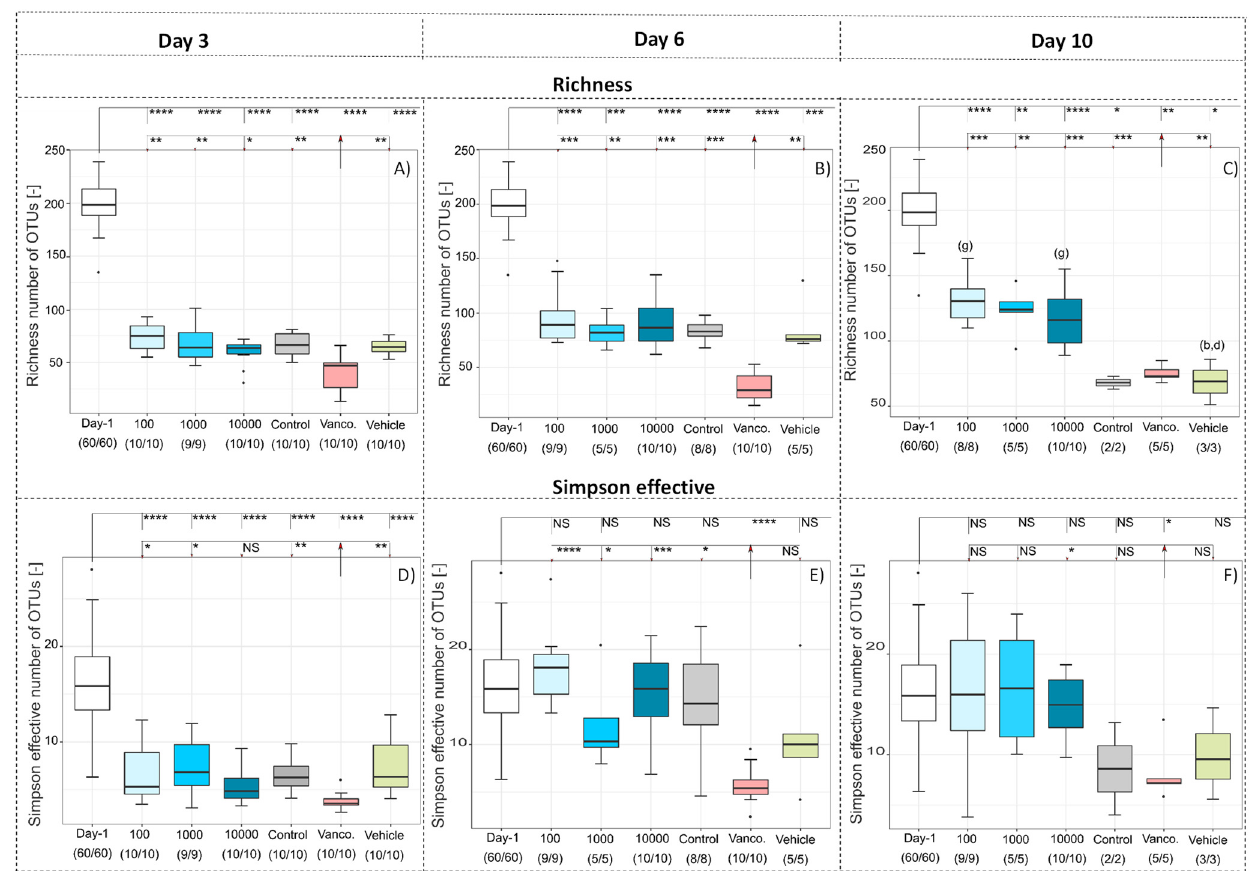
Figure 1. Richness ( A – C ) and Simpson effective index ( D – F ) during the six different treatments (WPI 10,000, WPI 1000, WPI 100, control WPI, Vancomycin, Vehicle) after 3 ( A , D ), 6 ( B , E ) and 10 ( C , F ) days compared to the 60 values of the hamsters before treatment (day -1). Significance values are p < 0.05 = *, p < 0.01 = **, p < 0.001 = ***, p < 0.0001 = ****, NS = not significant. Significant differences between the groups are marked by small letters. The number in parentheses indicates the number of samples and correlates with the number of hamsters surviving at that time.